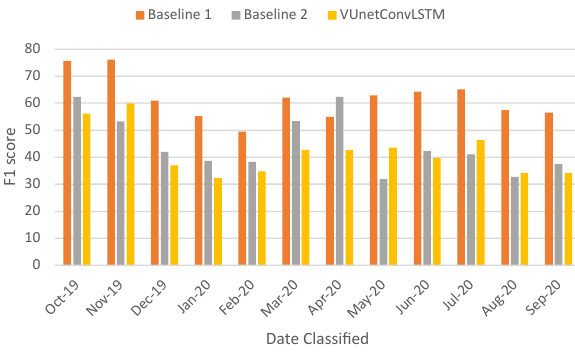
Figure 9. Per-date average F1 score for the proposed approaches.